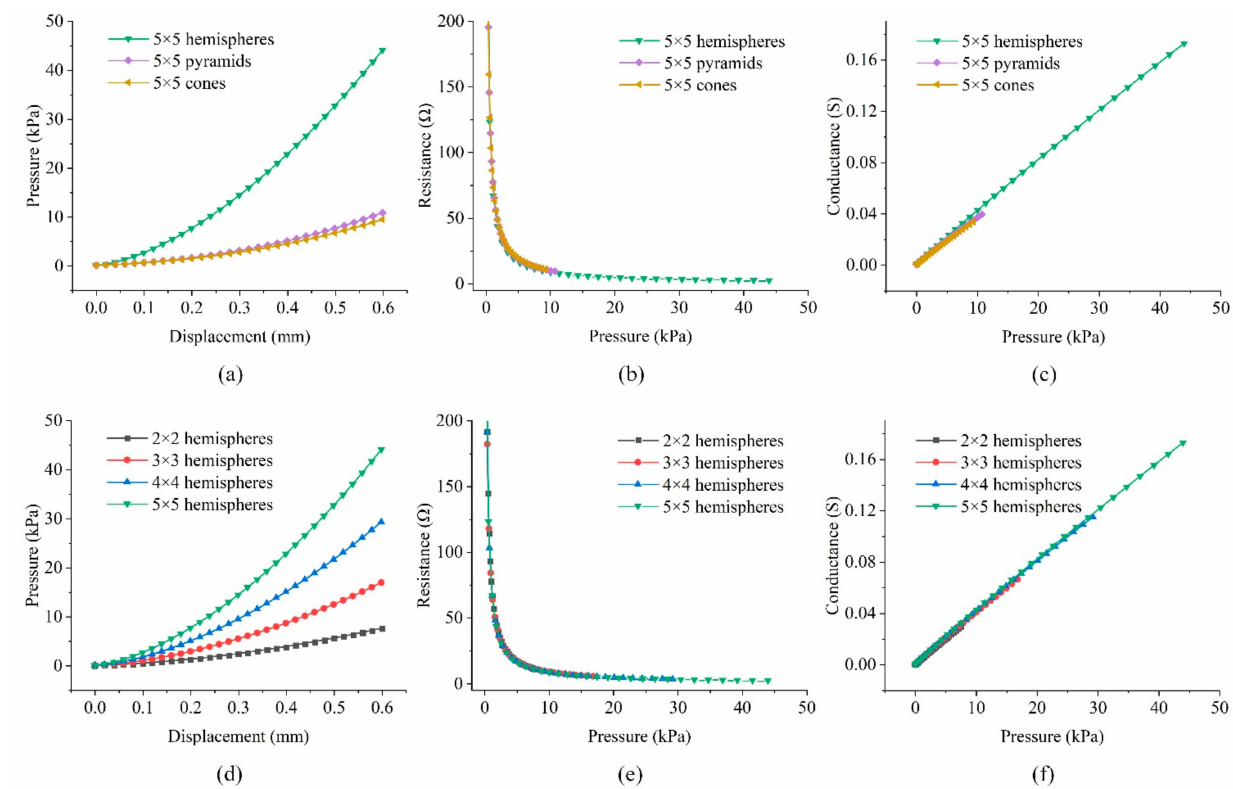
Figure 3. FEM results of the sensors with different microstructures: ( a – c ) Sensors with 5 × 5 hemispheres, pyramids and cones; ( d – f ) Sensors with different density distribution of